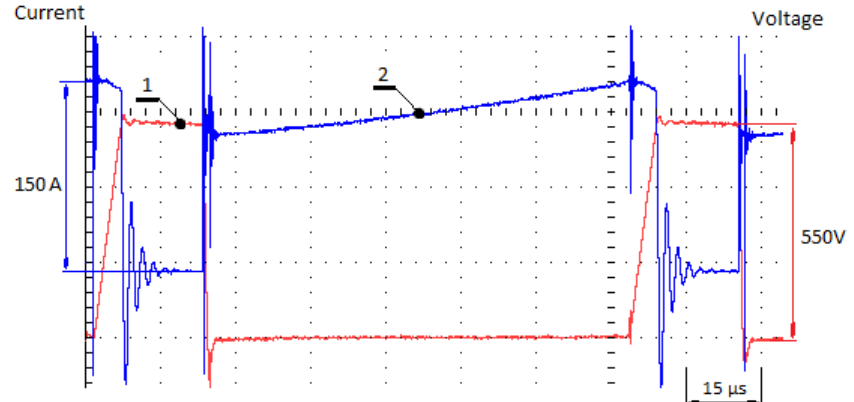
Figure 11. Buck mode of operation. 1–voltage gate-to-source Q1 (module M1, figure 2), 2–current through transistors Q1. Snubber capacitors are not included.